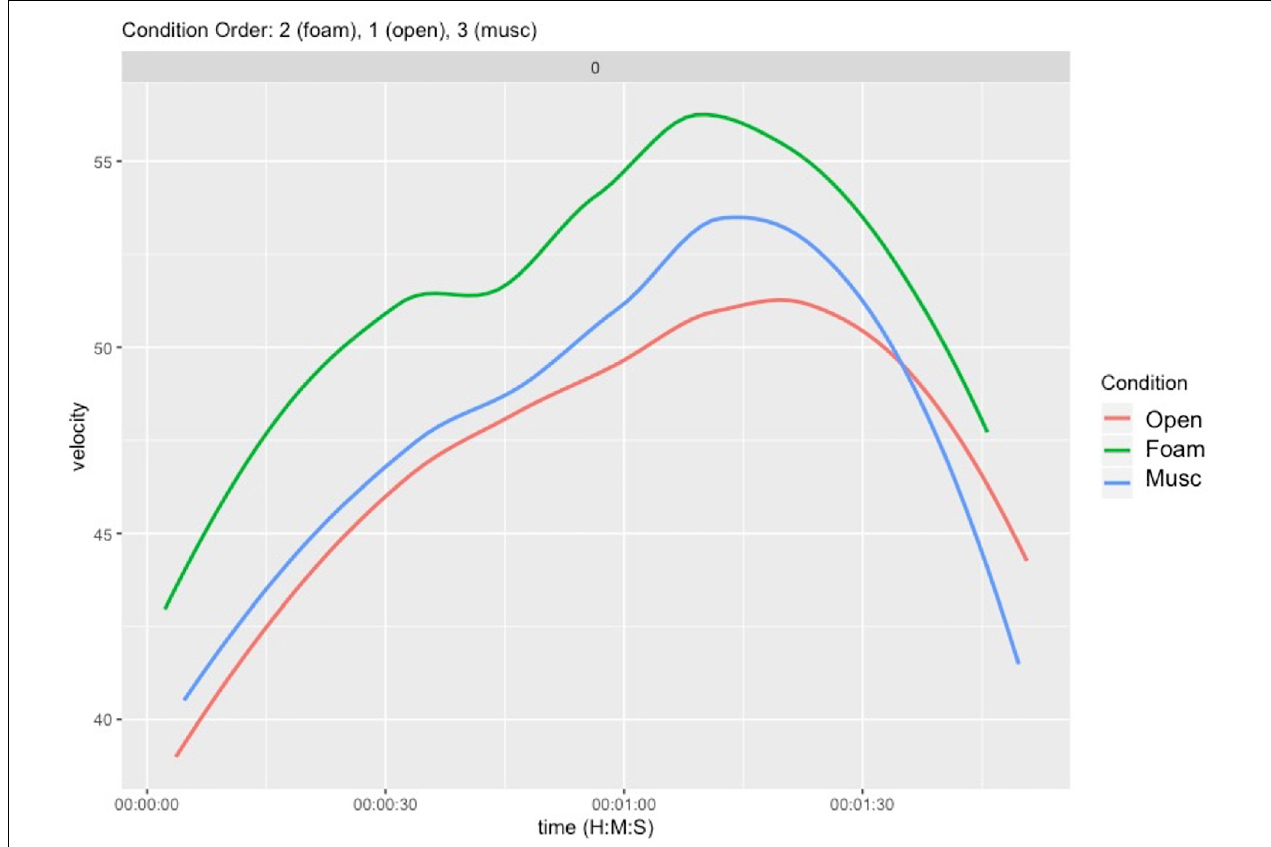
FIGURE 2 | Sample data from a participant performing a familiar excerpt E 0 in the three hearing conditions (Open, Musician earplugs, Foam earplugs).